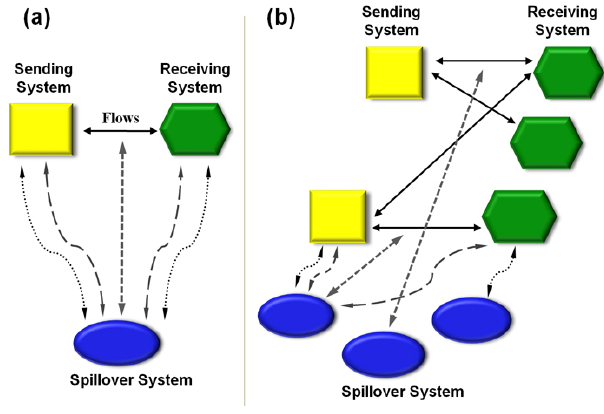
Fig. 3 . Example typologies of relationships between sending, receiving, and spillover systems. (A) represents one-one-one relationship and (B) represents select many- many-many relationships. Arrows indicate directions of flows. More arrows are possible between sending, receiving, and spillover systems but are omitted for the sake of simplicity. Spillover systems may be connected to sending and receiving systems in at least three ways: by being in the pathway between the sending and receiving systems (e.g., oil spill by tanker in transit; straight dashed arrow), by being an intermediate stopover between the sending and receiving systems (e.g., migratory bird stopover or airport layover; long-dashed curvy arrow), or by interacting with sending and/or receiving systems in other ways (e.g., third party in transnational land deals; short-dashed curvy